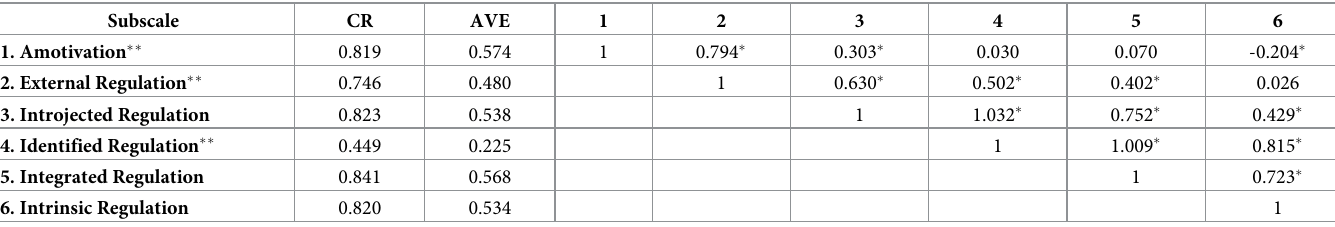
Table 3. CR, AVE, and standardised factor covariance for six-factor model 2 of BREQ-3M. Subscale CR AVE